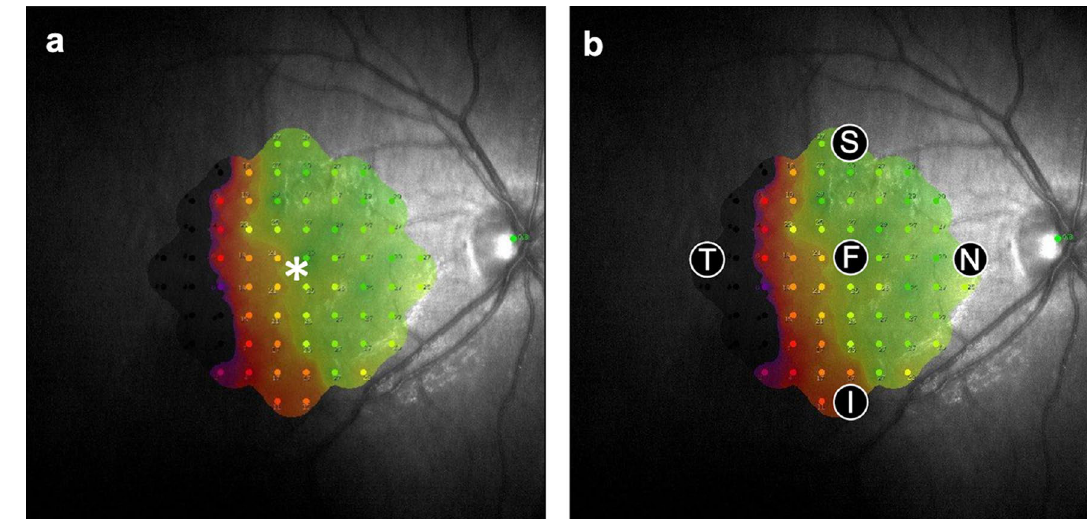
Figure 5. Definition of foveal and perifoveal points for the measurement of retinal sensitivity. The retinal sensitivity is measured using the Macular Integrity Assessment system. The foveal measurement point [F in ( b )] is defined as the measurement point closest to the fixation point [asterisk in ( a )]. The perifoveal measurement points are defined as the measurement points farthest from the fixation point, both horizontally and vertically [ S superior, I inferior, T temporal; N nasal; in ( b )].